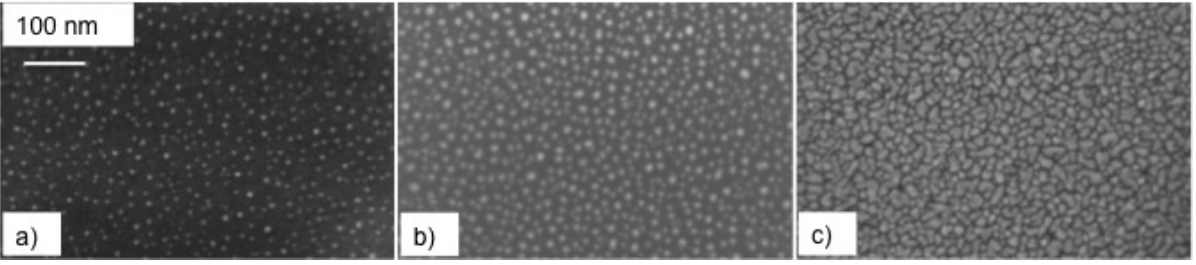
Figure 3. SEM images of the surface morphology of silver samples deposited at 70 Pa of Ar with: ( a ) 1000, ( b ) 10,000, and ( c ) 3 × 10 4 laser